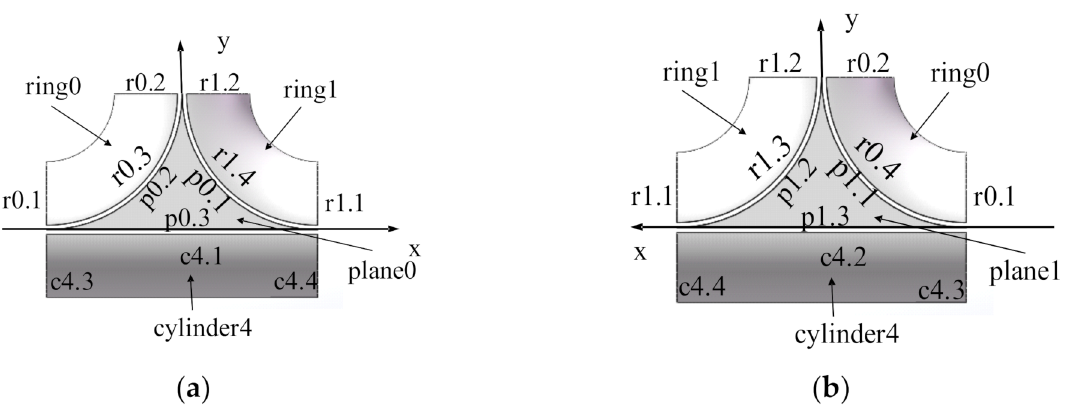
Figure 3. Schematics of T-junction patches: ( a ) Front view; ( b ) Postback